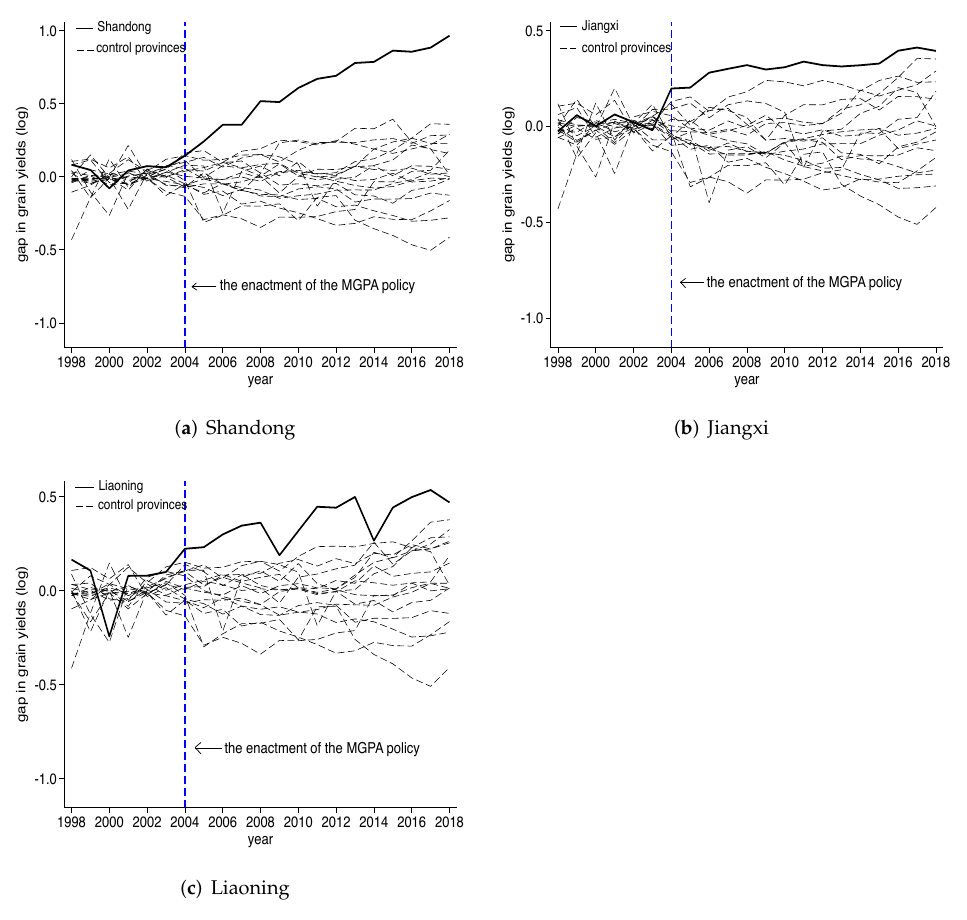
Figure 5. Synthetic control